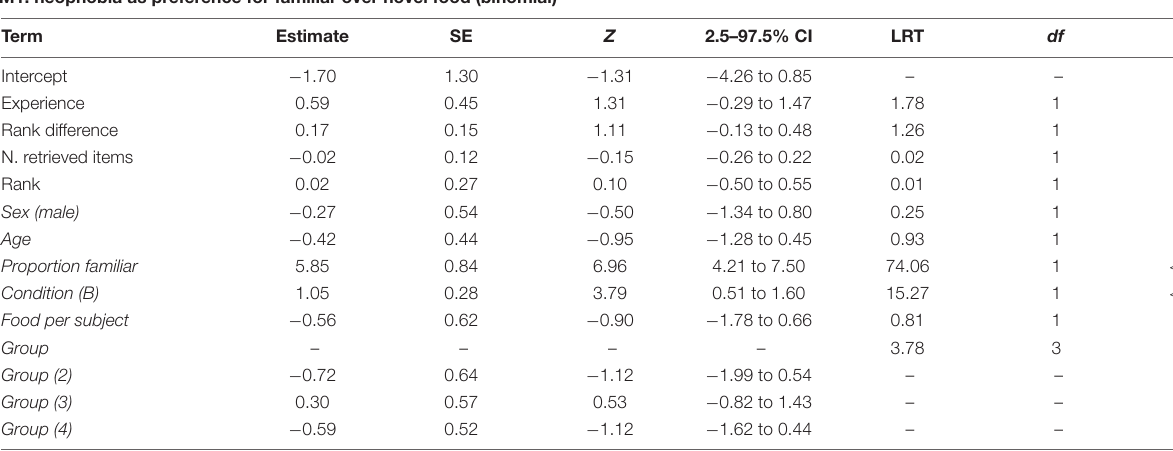
TABLE 2 | For models M1 and M2, test predictors and controls (in italics) included in the final model, estimates, standard errors (SE), z -values ( z ), confidence intervals (CIs), likelihood ratio test’s χ 2 (LRT), degrees of freedom ( df ) and p -values. M1: neophobia as preference for familiar over novel food